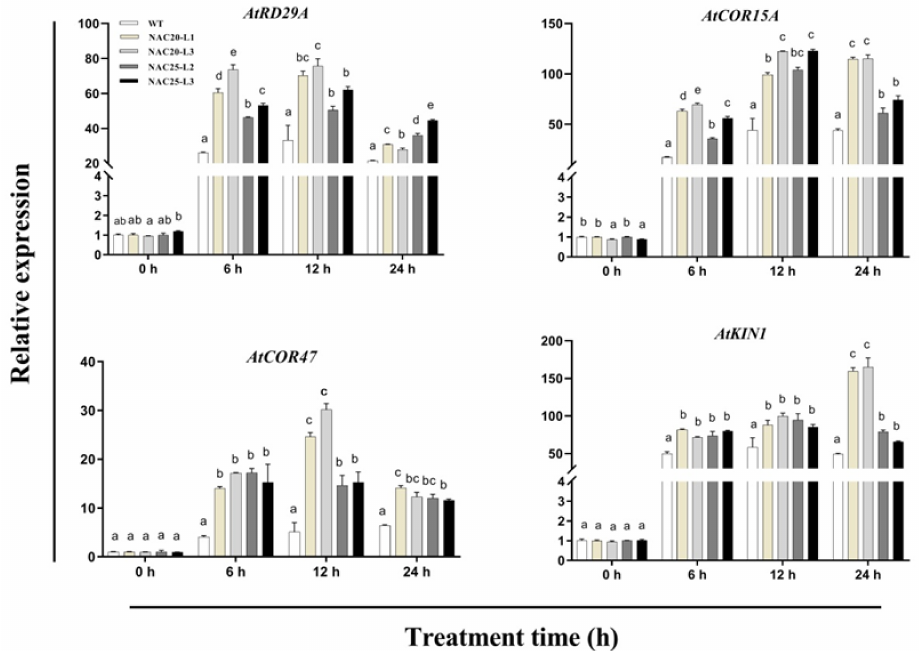
Figure 11. Expression analyses of AtRD29A , AtCOR15A , AtCOR47 , and AtKIN1 in WT and transgenic lines under cold stress. Data represented average values from three biological replicates ( ± S.D.). The different letters above bars indicated significant differences at the p < 0.05 level according to Duncan’s multiple comparison